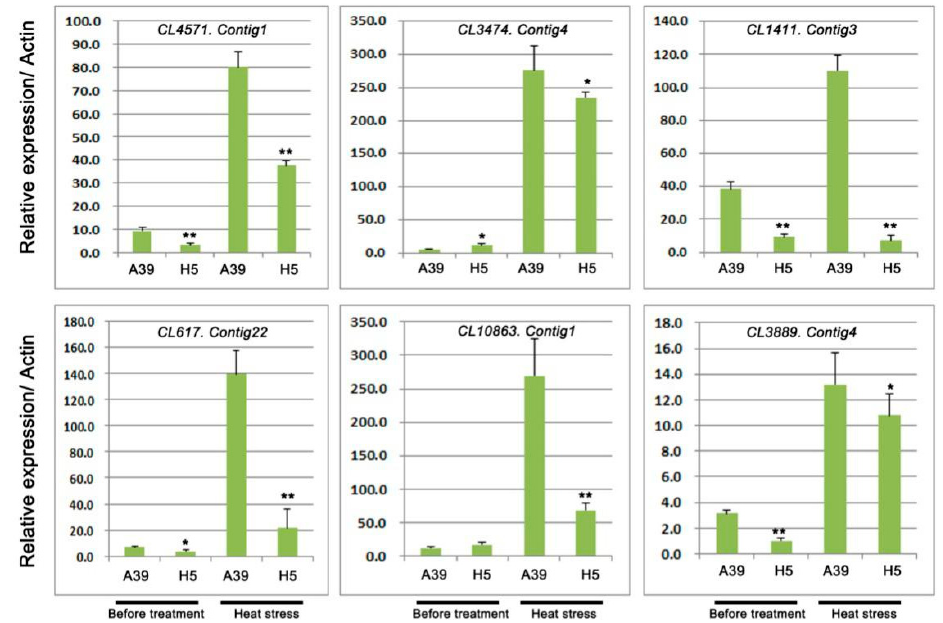
Figure 6. Relative expression of genes related to ubiquitin carboxyl-terminal hydrolases and E3 ubiquitin-protein ligases. Data are presented as the mean ± standard deviation ( n = 9). * 0.01 ≤ p ≤ 0.05, ** p ≤ 0.01, Student’s t test.